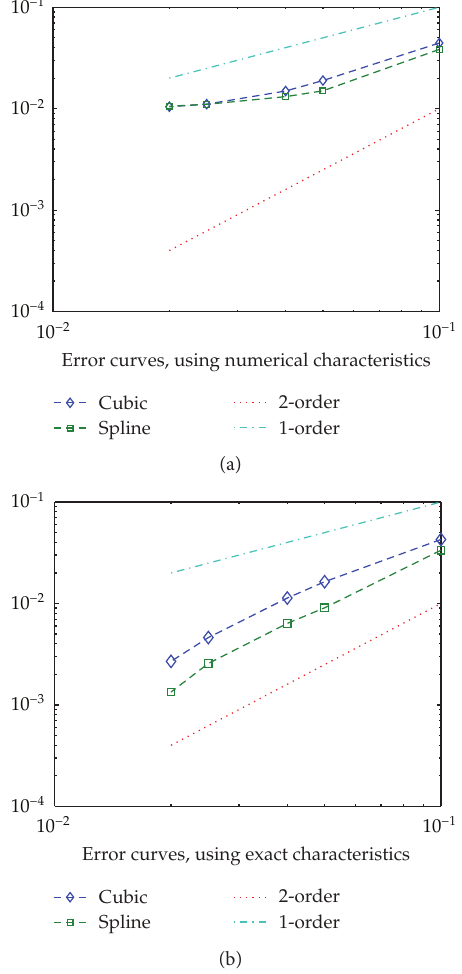
Figure 2: 𝐸 𝑙 2 -error of CN scheme versus Δ𝑡 in log-log scale, with 𝑇 = 𝜋/4 , 𝜈 = 1.25 × 10 −4 ; ℎ = Δ𝑡 = 0.1, 0.05, 0.04, 0.25, 0.02 . Exact characteristic lines are involved in (a) and numerical ones in (b).